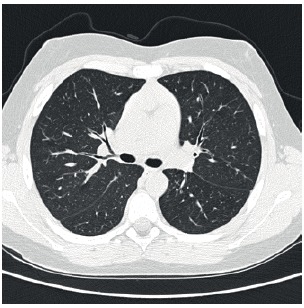
TCAR de tórax revelando exuberantes alterações em vidro fosco em ambos
os campos pulmonares, compatível com alveolite alérgica extrínseca.